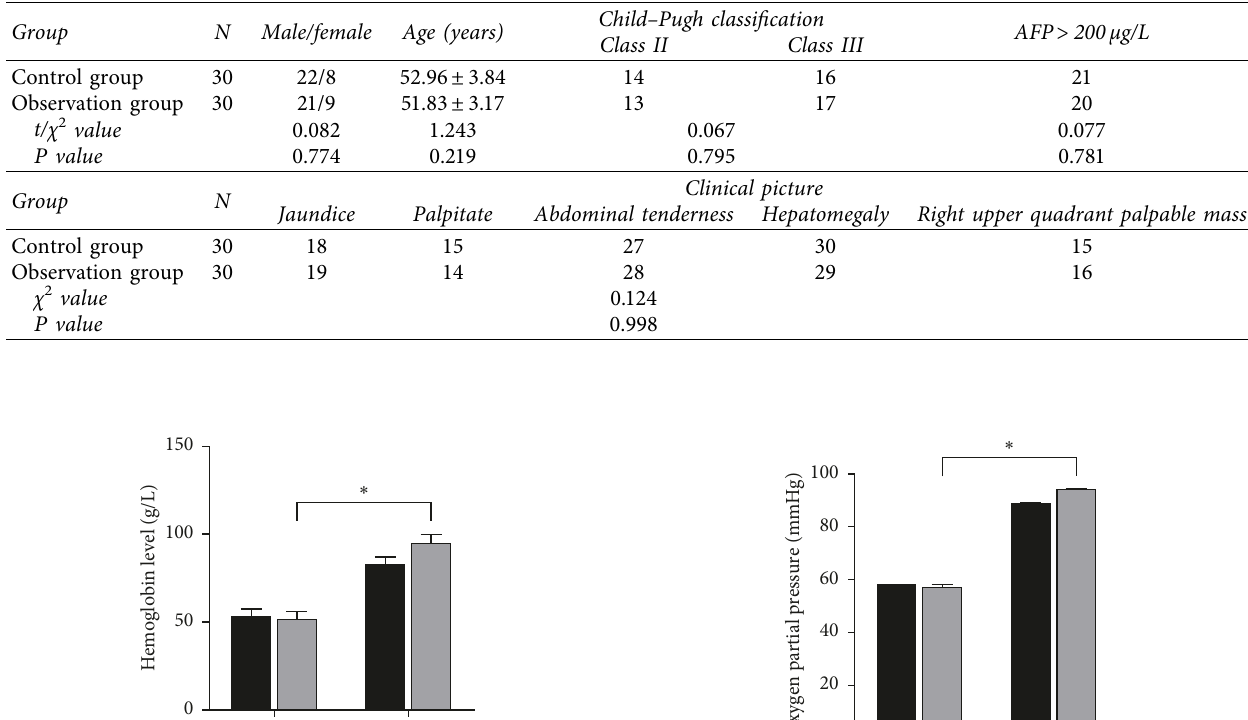
Table 1: Comparison of general data between the two groups.